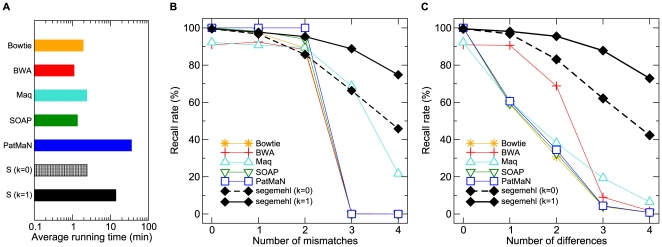
Comparison of recall rates and running time for several short read aligners.Average running time for the different programs (A) in matching runs with 500 000 reads in two different data sets (logarithmic scale; S refers to segemehl). The differences are uniformly distributed and consist of only mismatches (B) or mismatches, insertions and deletions (C). The recall rate describes the fraction of reads which was mapped to the correct position. All programs were used with default parameters. Bowtie was called with option –all and SOAP with option –r 2.